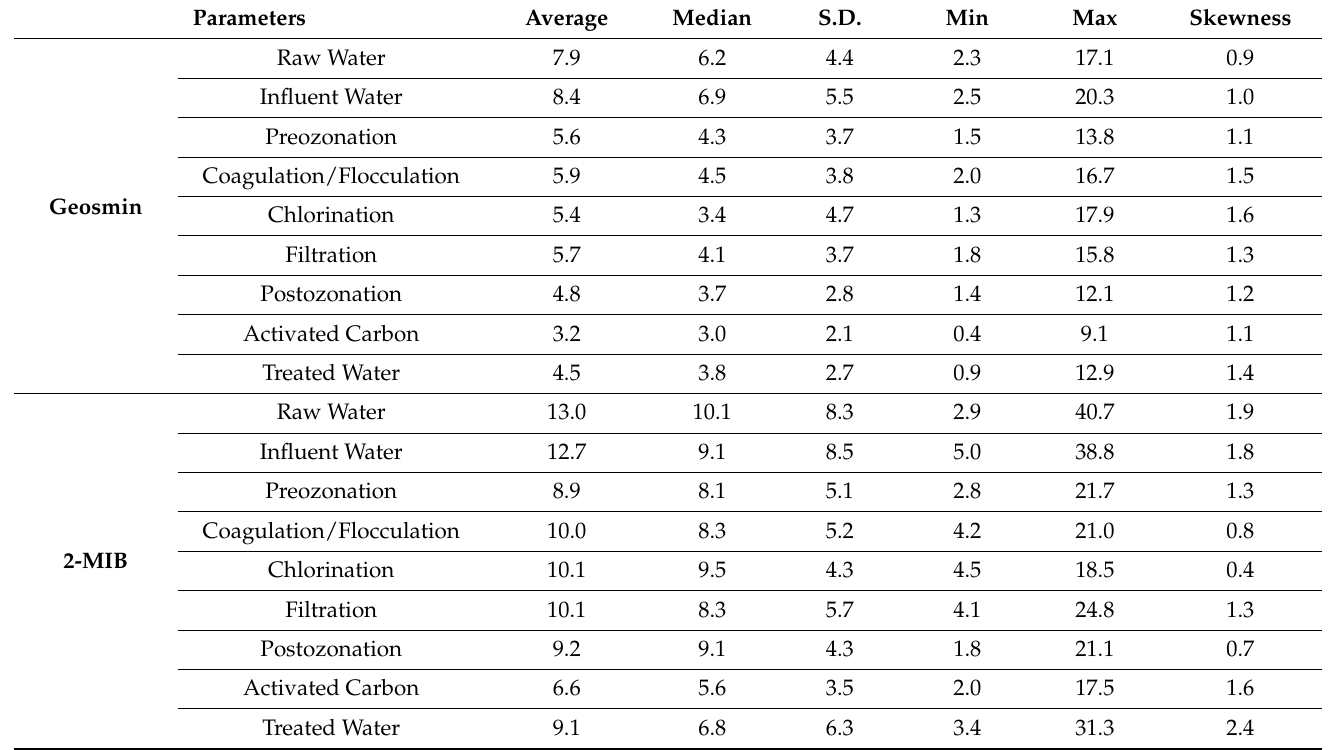
Figure 3. Concentrations of geosmin and 2-MIB affected by the returned water and the preozona- tion processes. Table 4. The statistical data of the geosmin and 2-MIB concentrations affected by treatment